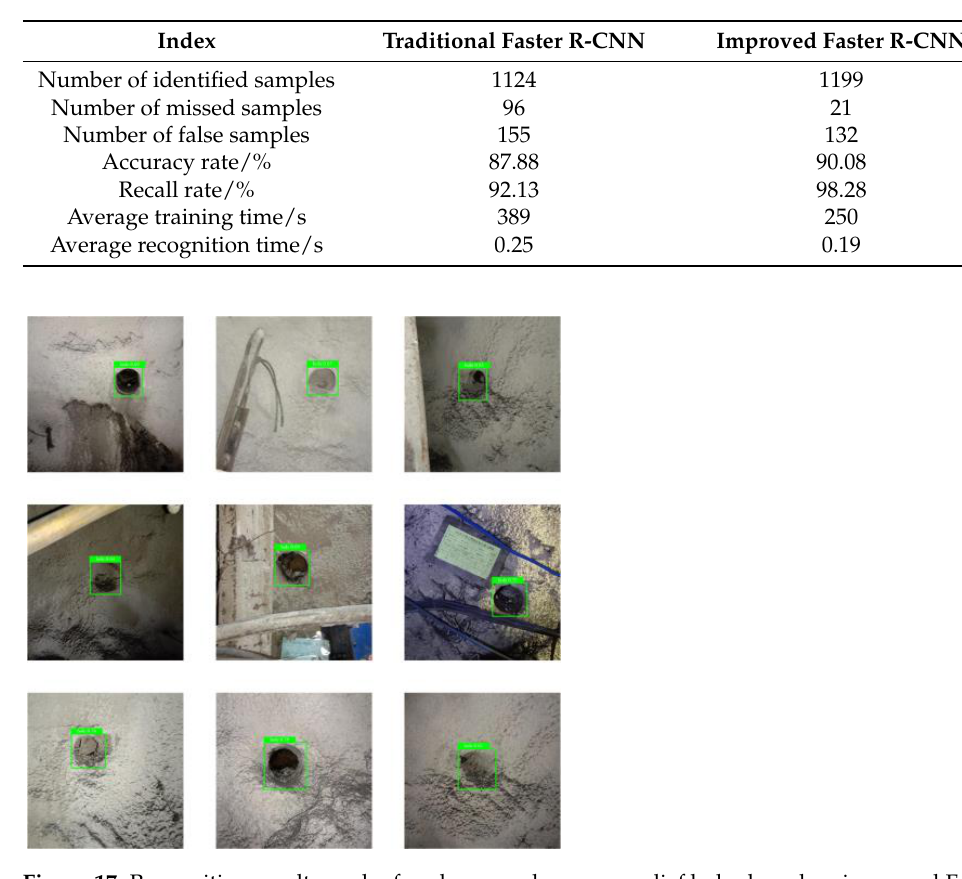
Table 6. Relief hole target recognition results based on the improved SqueezeNet + BN model with different measures.